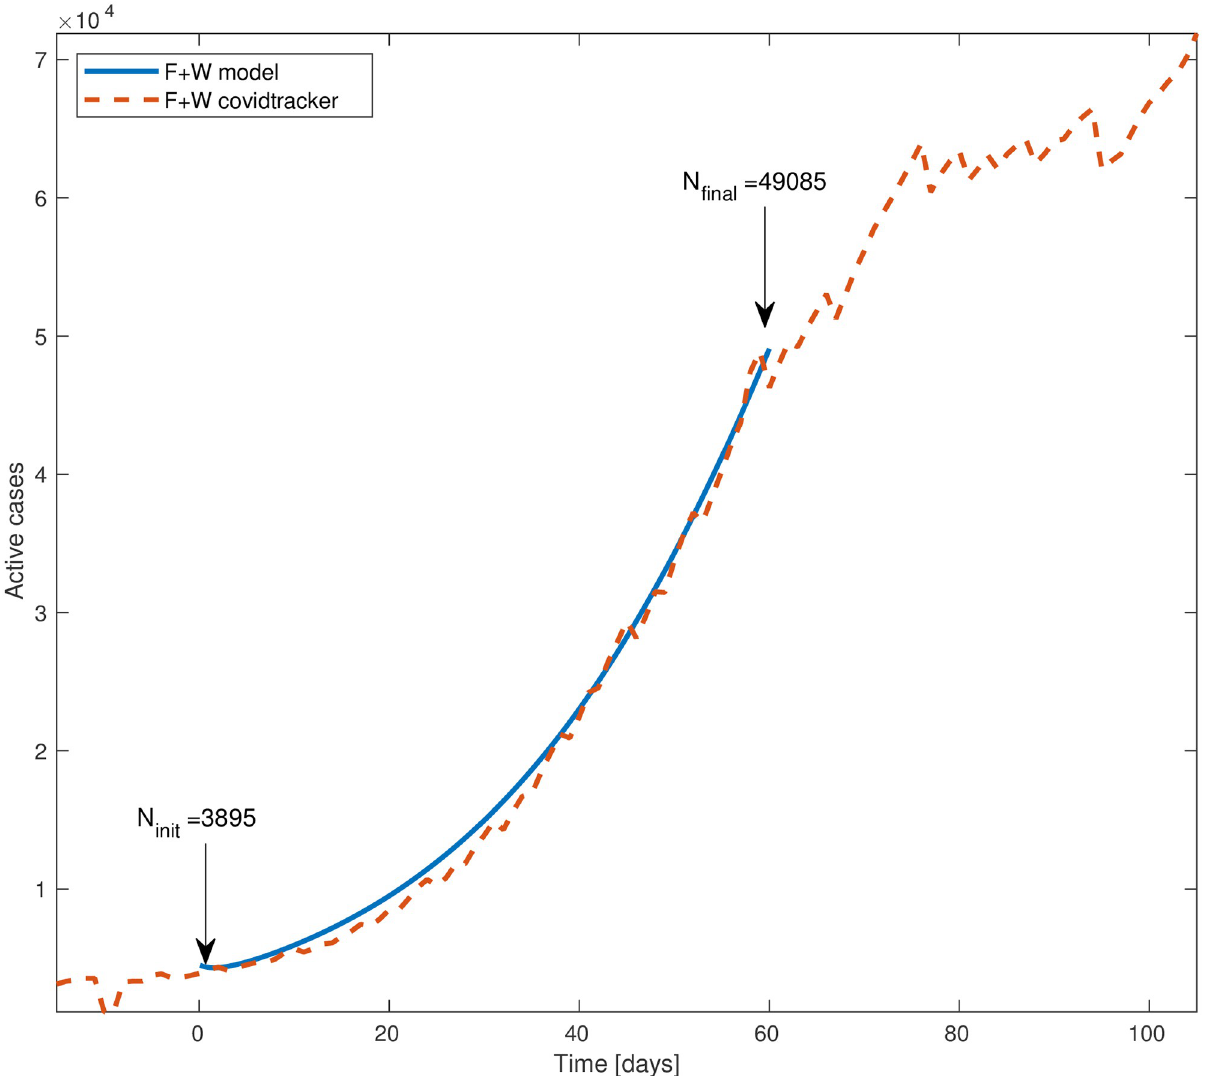
Fig 6. Total number of active cases (‘ F ’ + ‘ W ’) in South Carolina vs time. Blue line is the model simulation and red dashed curve is the number provided by Covidtracking. The model input is the total number of active cases at time t = 0 (May 22, 2020), 3895. The final number of cases of the model is 49, 085, about 6% above the reported number, 46, 275. We assumed the basic reproductive rate R 0 = 1.9 to be constant throughout the whole inspected